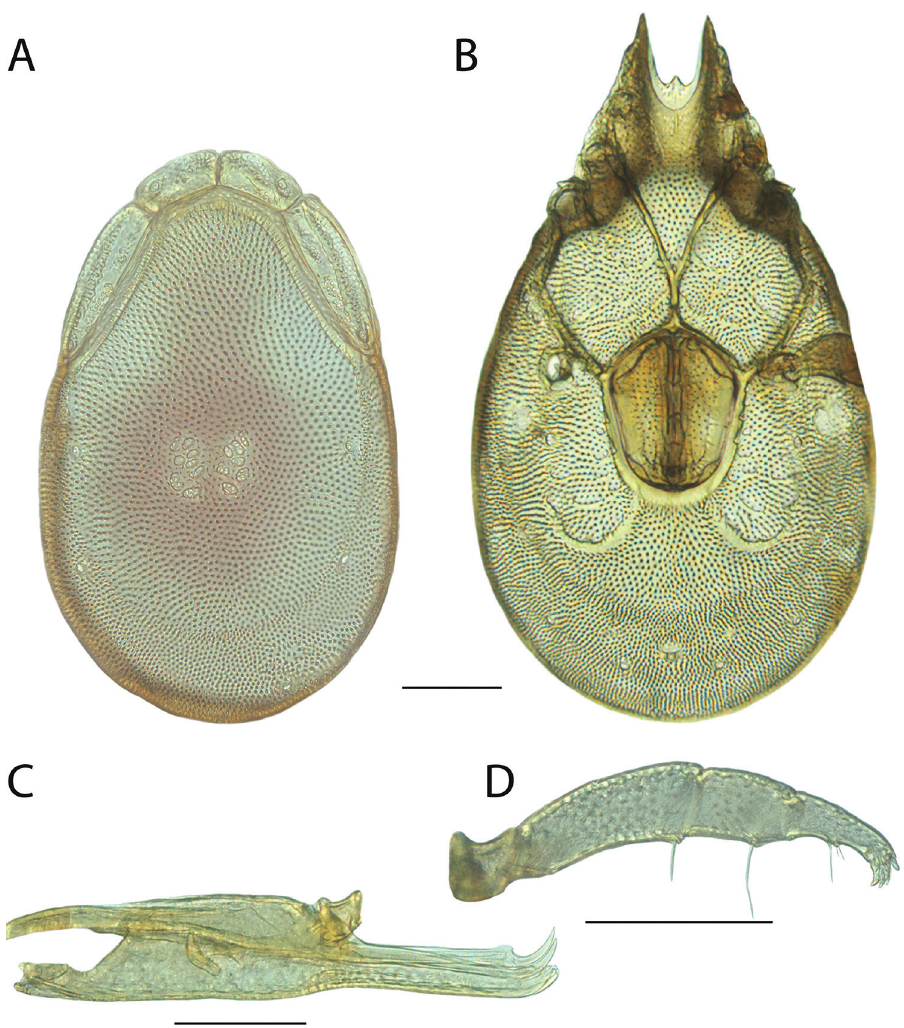
Figure 200. Torrenticola projector female: A dorsal plates B venter (legs removed) C subcapitulum D pe- dipalp (setae not accurately depicted). Scale = 100